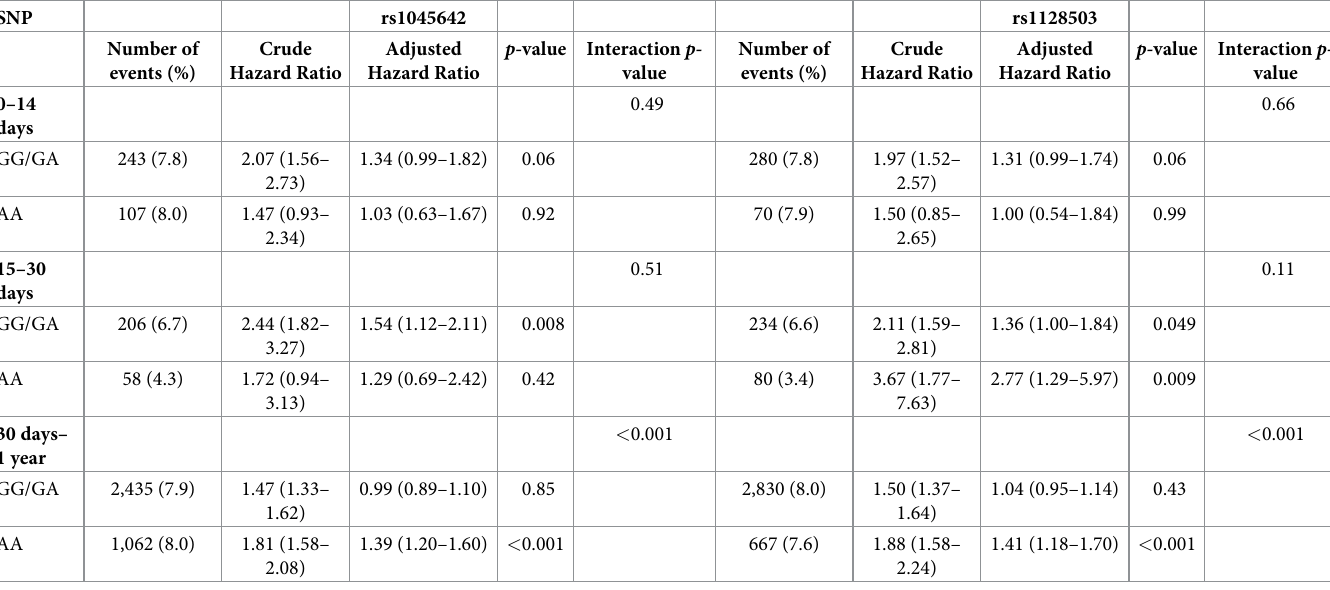
Table 6. Association of clarithromycin and cardiovascular hospitalization (versus amoxicillin) stratified by P-glycoprotein